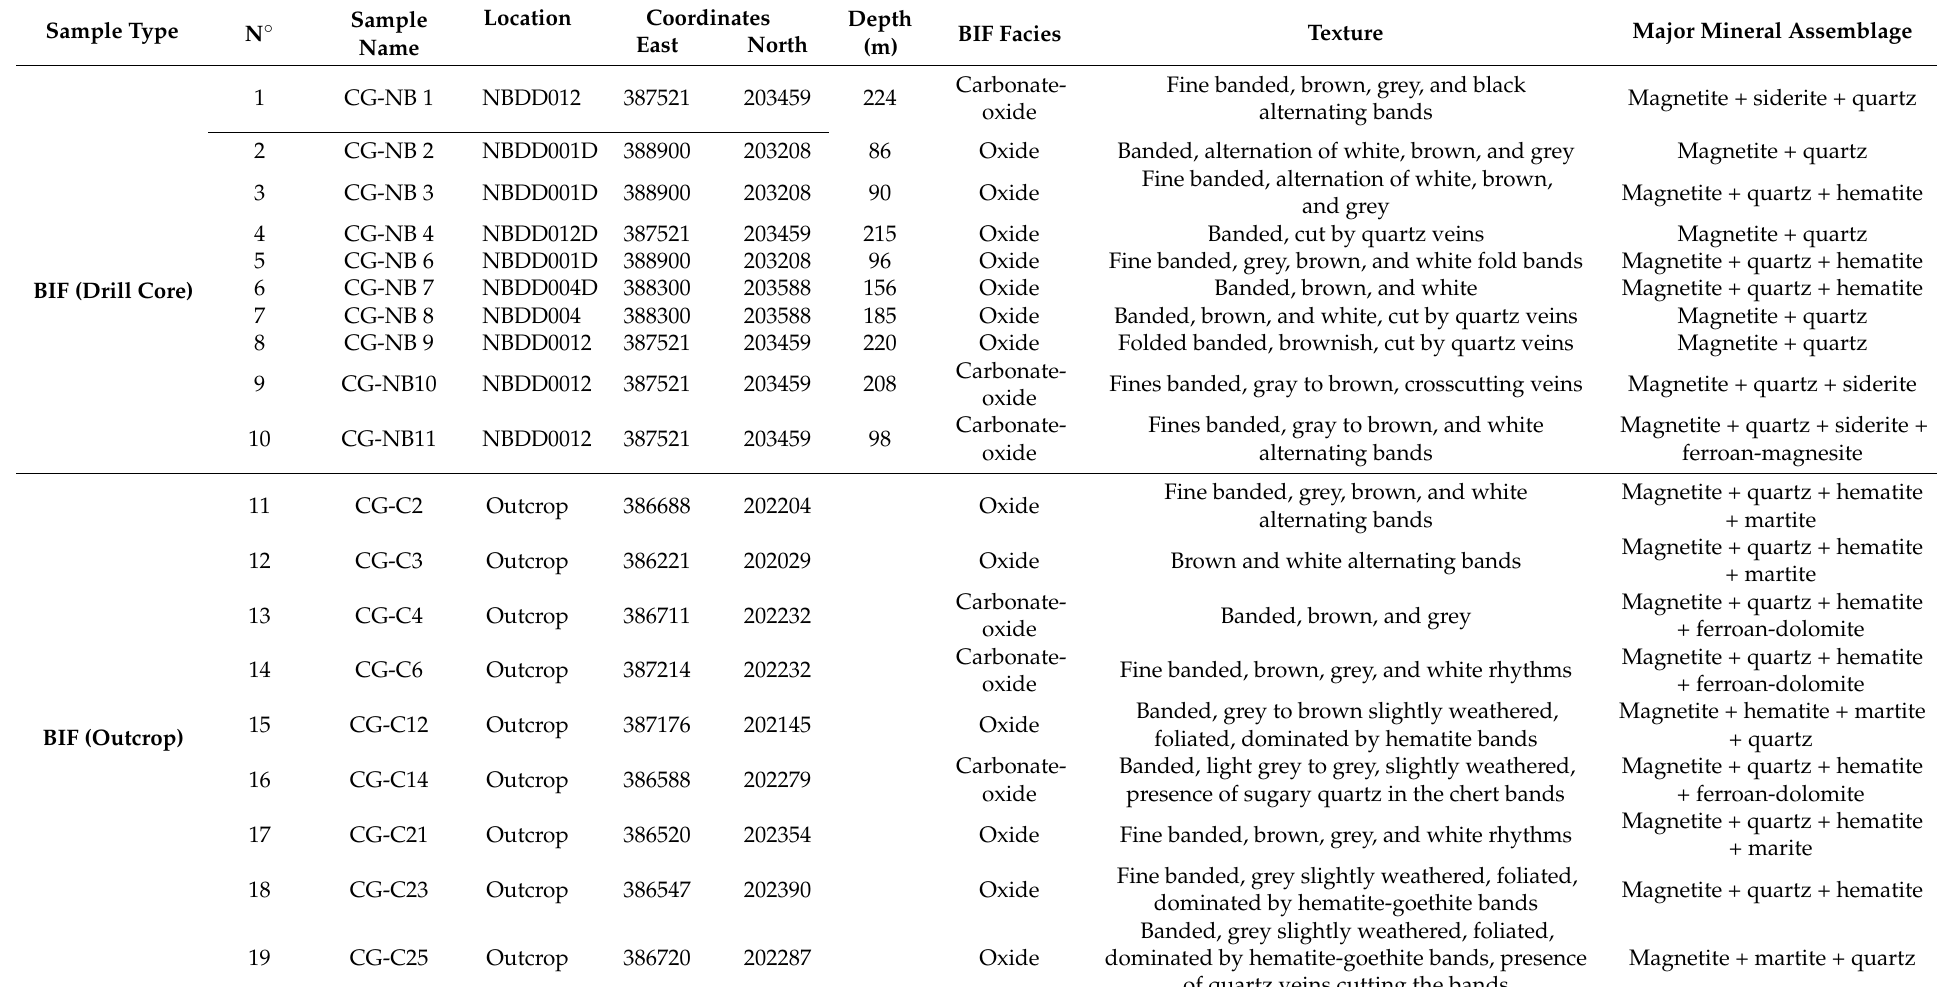
Table 1. Samples collected from the Nabeba iron